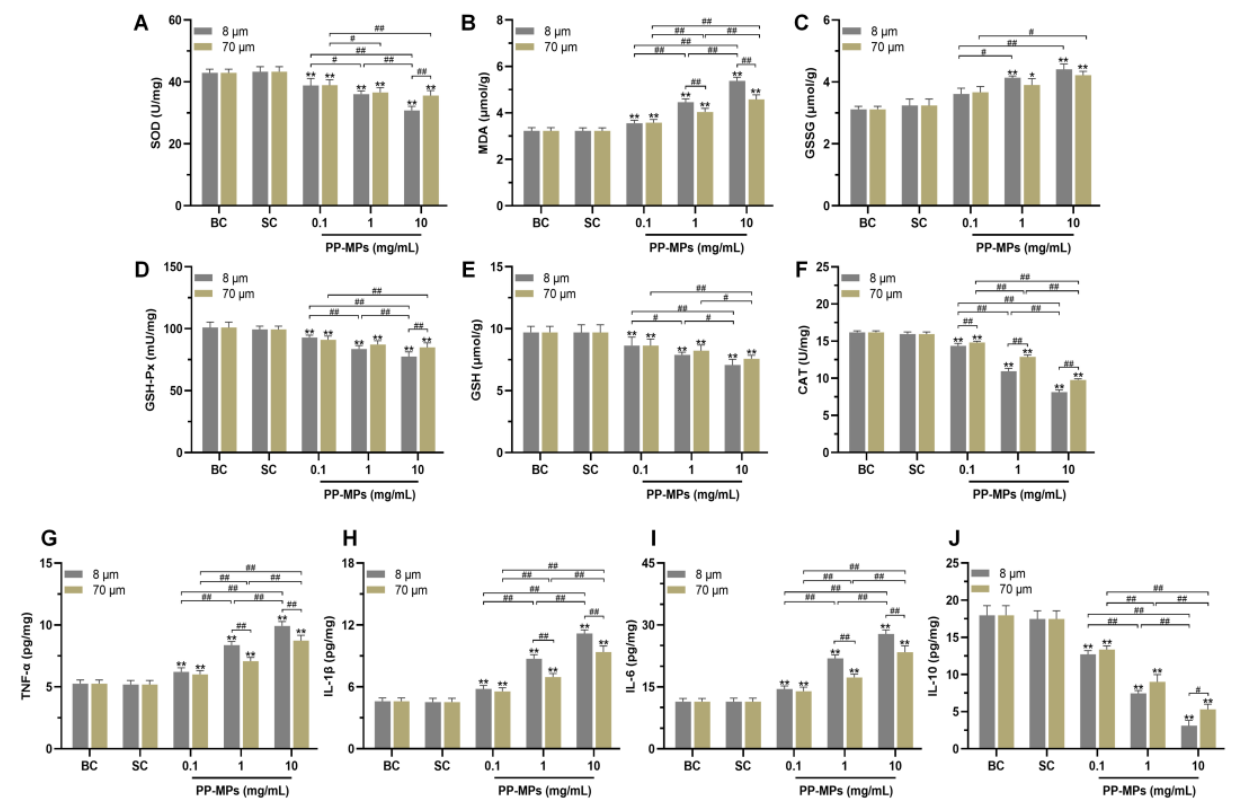
Figure 3. Oxidative stress and inflammation occurred in the colon of mice after PP-MP exposure. ( A – F ) Colonic levels of SOD ( A ), MDA ( B ), GSSG ( C ), GSH-Px ( D ), GSH ( E ), and CAT ( F ). ( G – J ) Colonic levels of TNF- α ( G ), IL-1 β ( H ), IL-6 ( I ), and IL-10 ( J ). The presented values are the means ± SD ( n = 5). # p < 0.05, ## p < 0.01 between PP-MP treated groups, and * p < 0.05, ** p < 0.01 vs. SC as determined by one-way analysis of variance (ANOVA). BC: blank control (pure water); SC: solvent control (pure water containing 0.01% v / v Tween-80); PP-MPs: polypropylene microplastics.